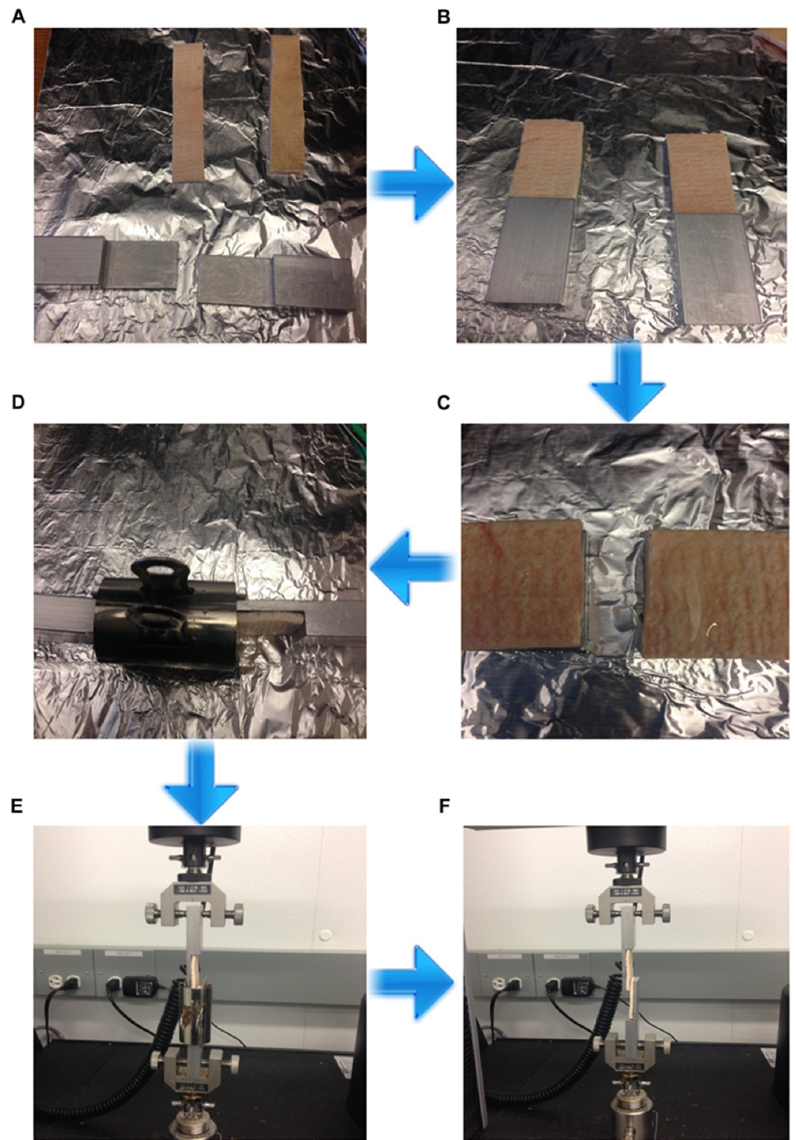
Figure 5. Schematic diagram of bonding strength process. ( A ) The skin graft was cut into the dimensions of 5.08 cm × 2.54 cm × 0.24 cm with a #20 Uniblade TM disposable surgical scalpel (AD Surgical, Sunnyvale, CA, USA). ( B ) The skin strip was glued on an aluminum block with dermal side up by using a Loctite super glue (Henkel Corporation, Rocky Hill, CT, USA). A total of 80 µ L of WPI solution and 20 µ L of GTA solution were applied on the skin dermal side and mixed with a small steel spatula and then the two porcine skin strips were overlapped together by the fixture ( C ). The bonding area was 2.54 cm × 1.0 cm. Glued specimens were kept for 30 min ( D ) and tested by an Instron 5566 machine (Instron Corporation, Norwood, MA, USA). ( E , F ) Specimens were put tightly in the loading cell of the Instron and the test was started until the two porcine skin stripes separated. The maximum load (N) was recorded and the bonding strength (kPa) was